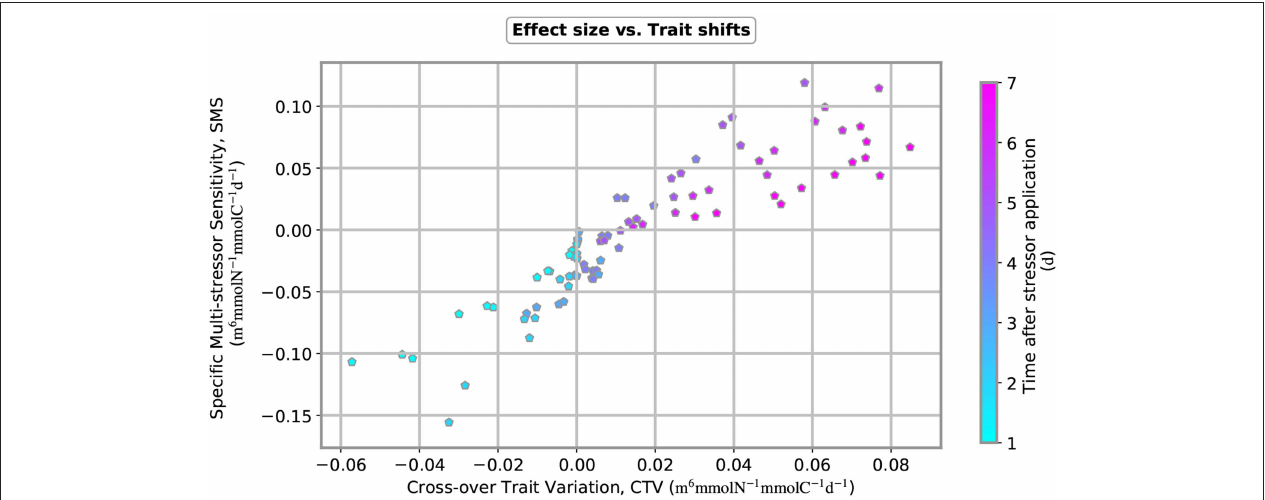
FIGURE 7 | Specific multi-stressor sensitivity (SMS) plotted over cross-trait variation (CTV) for 12 multi-stressor experiments. Nutrient input was varied from 0.2, 0.4, 0.8 to 1.6 mmol-N m − 3 and copepod removal from 0.4, 1.3 to 2.5 mmol-C m − 3 . Both measures, SMS and CTV, change over time after stressor application, as indicated by the color coding of the plot